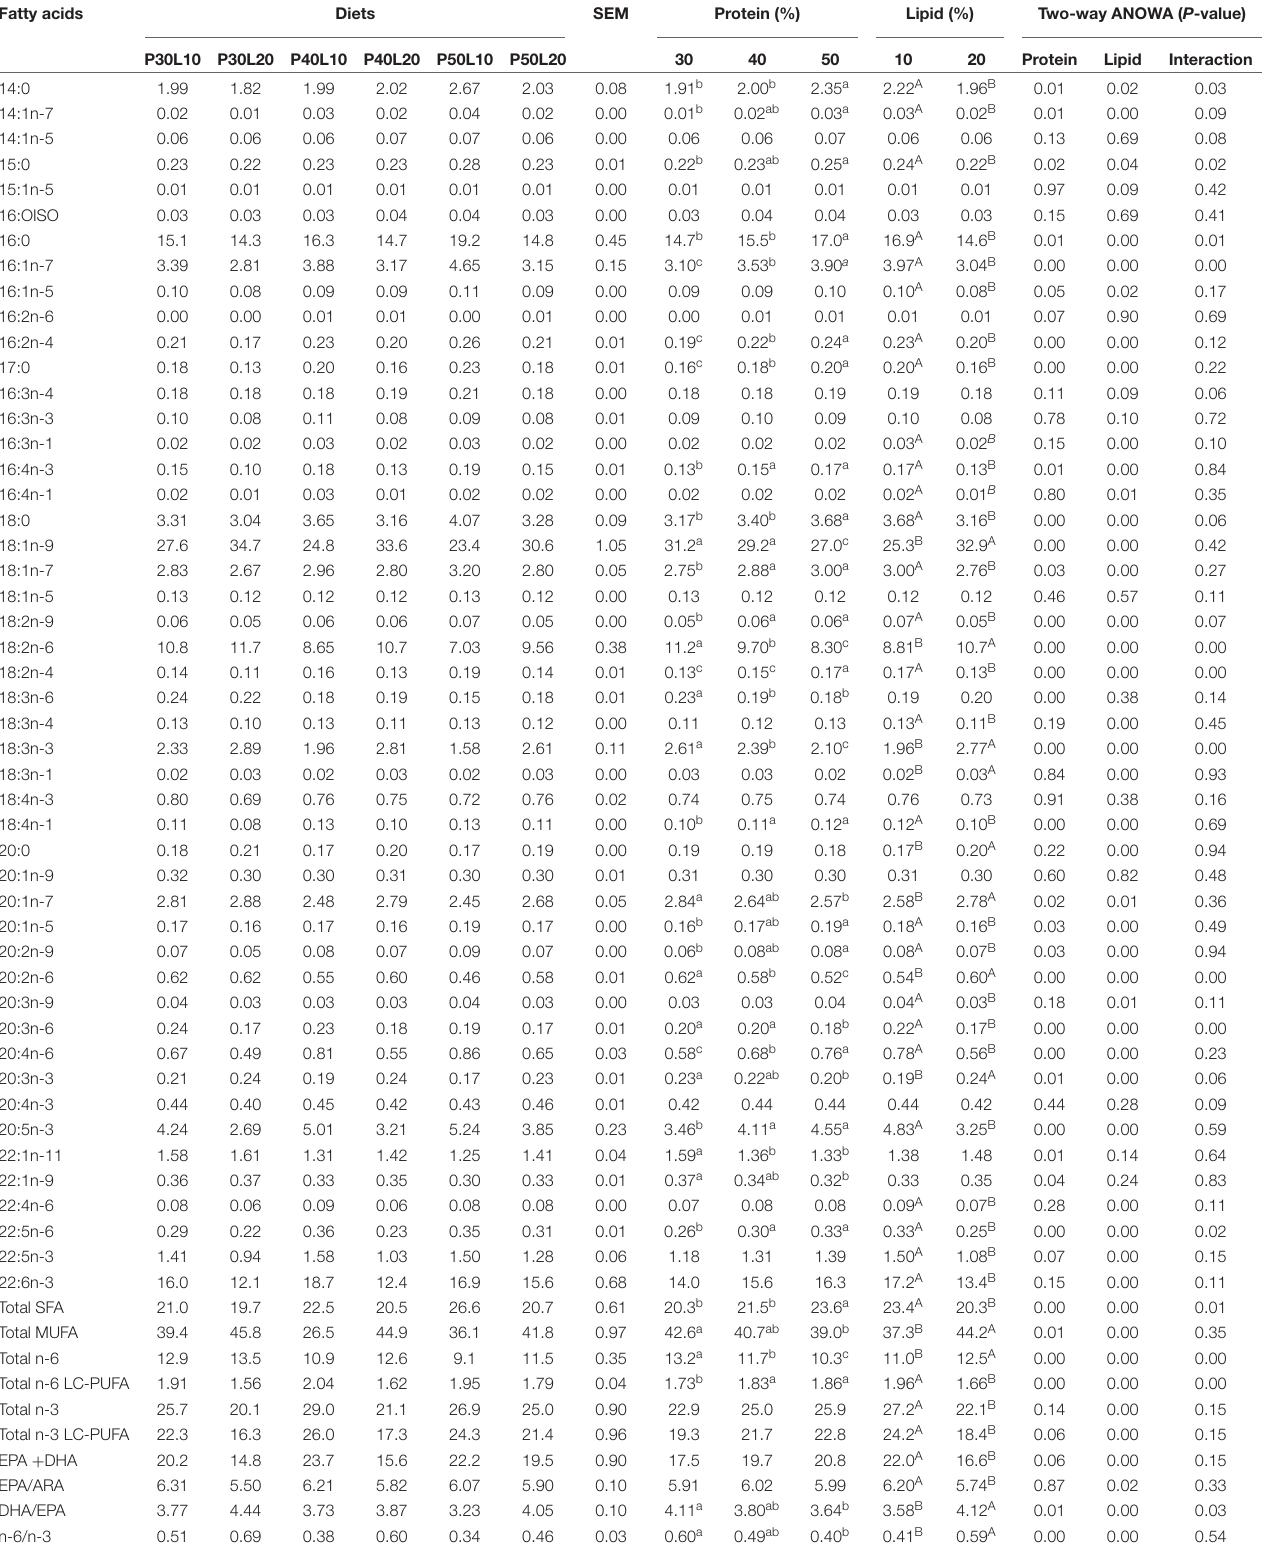
TABLE 6 | Dorsal muscle fatty acid composition of European grayling ( Thymallus thymallus ) fed the experimental diets for 12 weeks (% total identified FA). Fatty acids Diets SEM Protein (%) Lipid (%) Two-way ANOWA ( P